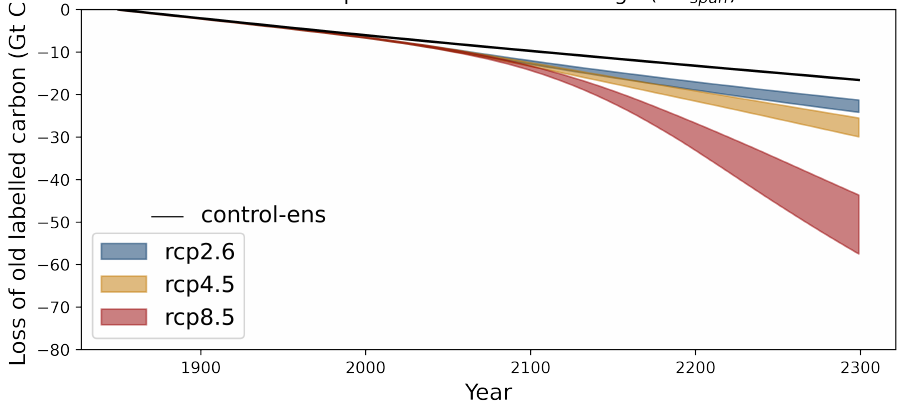
Figure A2. The cumulative loss of labelled permafrost carbon caused by the on-going small exchange between the carbon above and the labelled carbon below the permafrost table in a stable climate for CN spun . The black line is for the control-ens and the shaded areas show the range of the transient-ens and the differences between the black line and shaded area represent the loss of permafrost